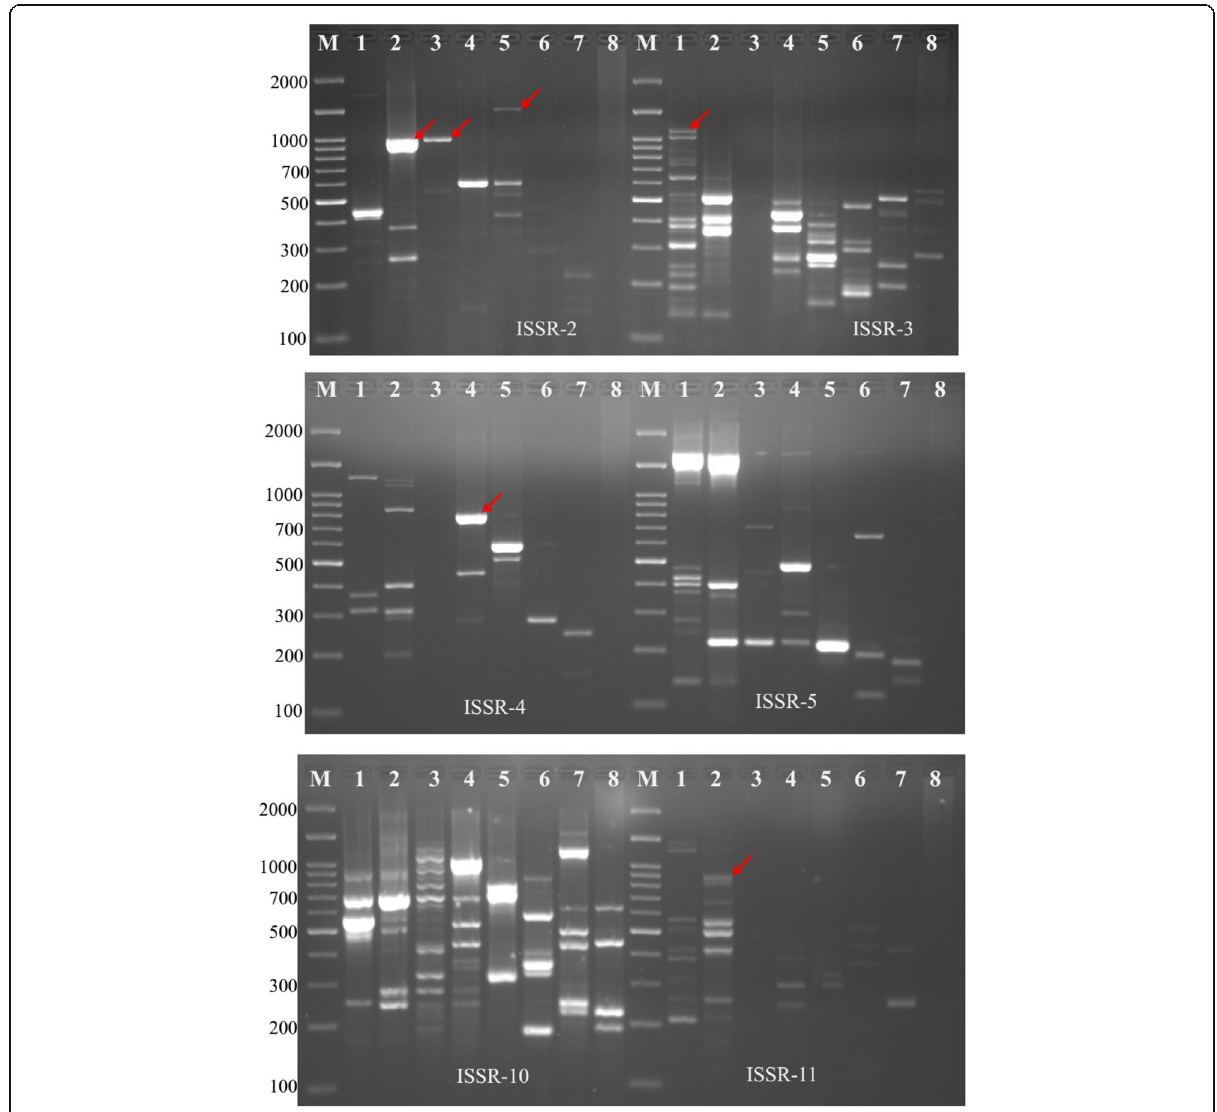
Fig. 3 ISSR-PCR profile of the eight Trichoderma strains using ISSR-2, ISSR-3, ISSR-4, ISSR-5, ISSR-10, and ISSR-11 primers. The amplification of DNA from the different species of Trichoderma was used for detecting the polymorphic bands among the isolates. The red arrows showed the species- specific bands in some Trichoderma spp. Lane 1, 100 bp DNA